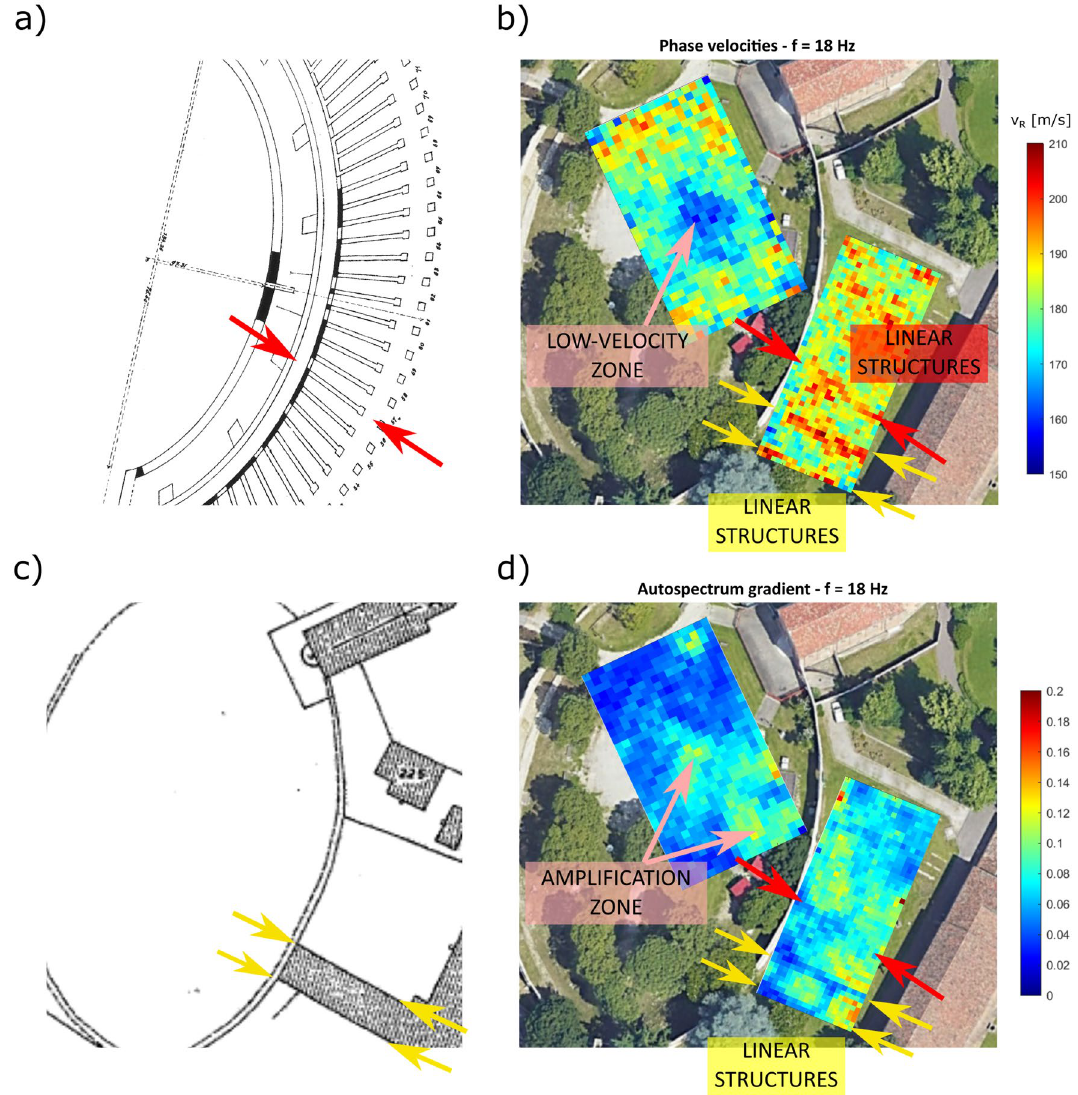
Figure 2. ( a ) Detail of Brunelli Bonetti’s hypothetical reconstruction of the amphitheater (modified from Bressan 27 ). ( b ) Phase velocity map for 18 Hz. ( c ) Cadastral map of Padua dating back 1966. ( d ) Autospectrum gradient map at 18 Hz. The corresponding features are highlighted with arrows of the same